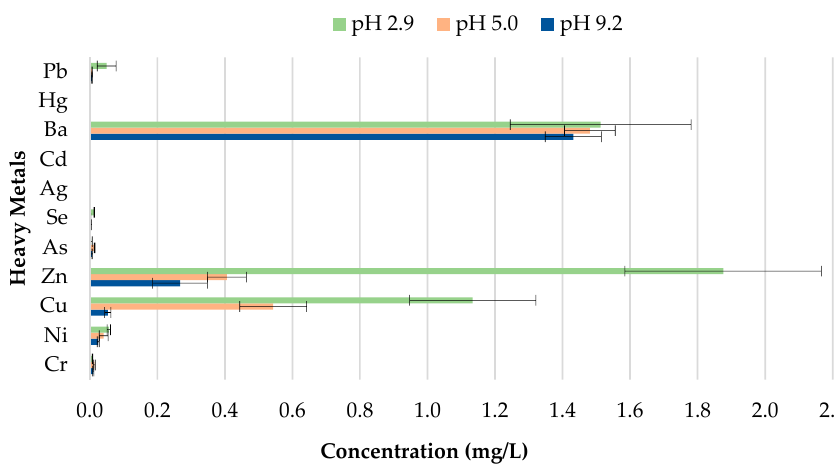
Figure 12. Leachate concentrations for crushed bricks with 0.5% CB content.